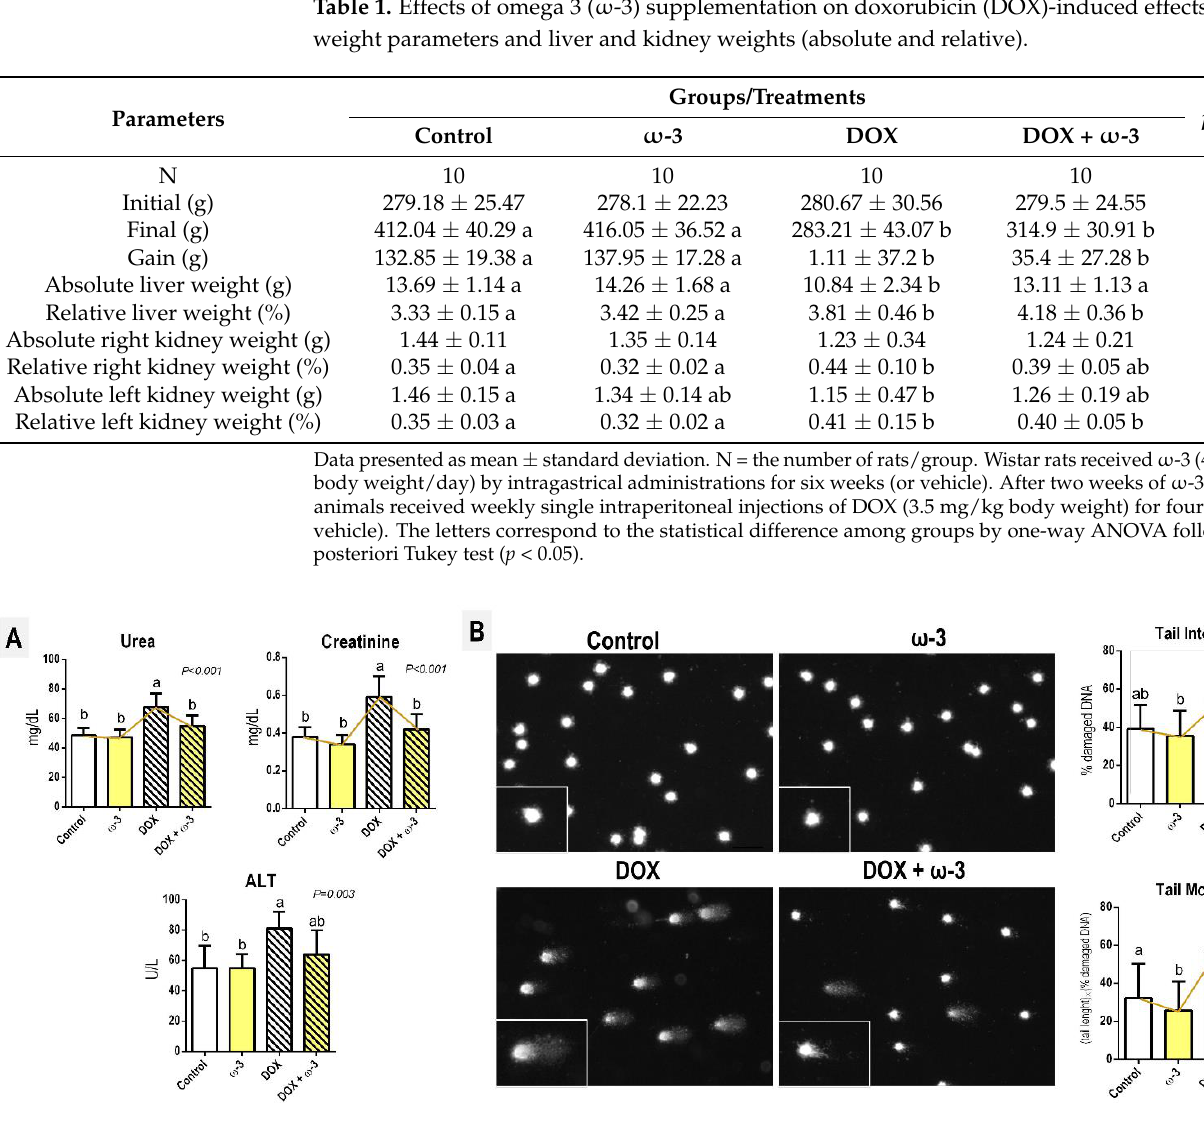
Figure 1. Effects of omega 3 (ω-3) supplementation on doxorubicin (DOX)-induced effects on ( A ) serum urea, creatinine, and alanine aminotransferase (ALT) levels; ( B ) peripheral blood genotoxicity. Representative photomicrographs of nucleoids are also presented. Data are presented as mean ± standard deviation. N = 5 (serum) or 8 (genotoxicity) rats/group. Male Wistar rats received ω-3 (400 mg/kg body weight/day) by intragastrical administrations for six weeks (or vehicle). After two weeks of ω-3 supplementation, animals received weekly single intraperitoneal injections of DOX (3.5 mg/kg body weight) for four weeks (or vehicle). The letters correspond to the statistical difference among groups by one-way ANOVA followed by a posteriori Tukey test ( p < 0.05). Vectors (yellow) interconnecting the medians depict the statistical modulation of DOX-induced effects by ω-3. 2.2. The ω -3 Supplementation Attenuates a DOX-Induced Increase in Blood Table 1. Effects of omega 3 (ω-3) supplementation on doxorubicin (DOX)-induced effects on body weight parameters and liver and kidney weights (absolute and relative).